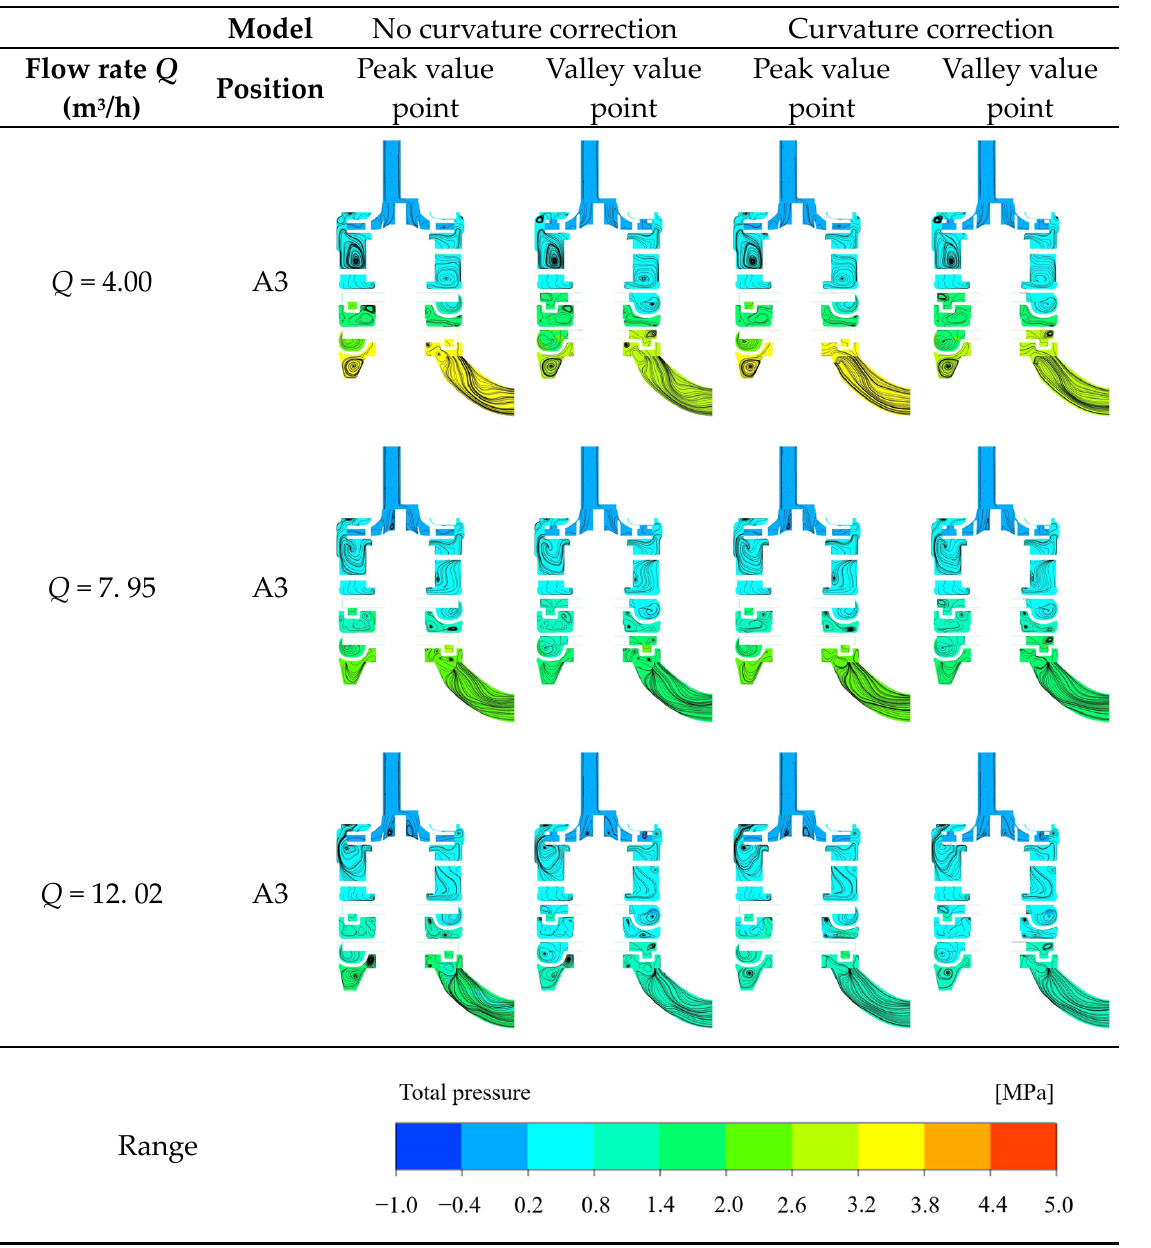
Figure 14. Meridional plane streamlines pressure distribution based on the DES model, with or without curvature correction at the peak and valley points of the head.